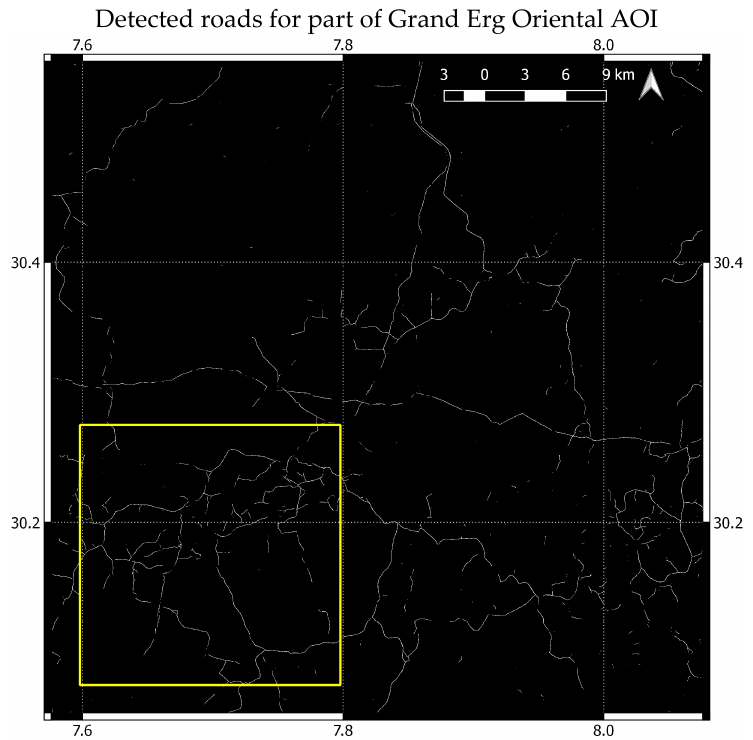
Figure 11. Detected roads for part of the Grand Erg Oriental AOI. The yellow rectangle shows a 0.2 × 0.2 degree subset over which roads were manually digitised and a performance evaluation carried out. This area is shown in more detail in Figure 12.